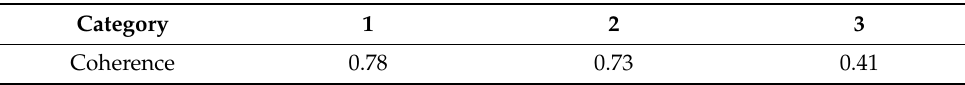
Figure 8. The relationship between the computational complexity and the number of updated atomic columns. Table 2. The coherence between S i and G i .